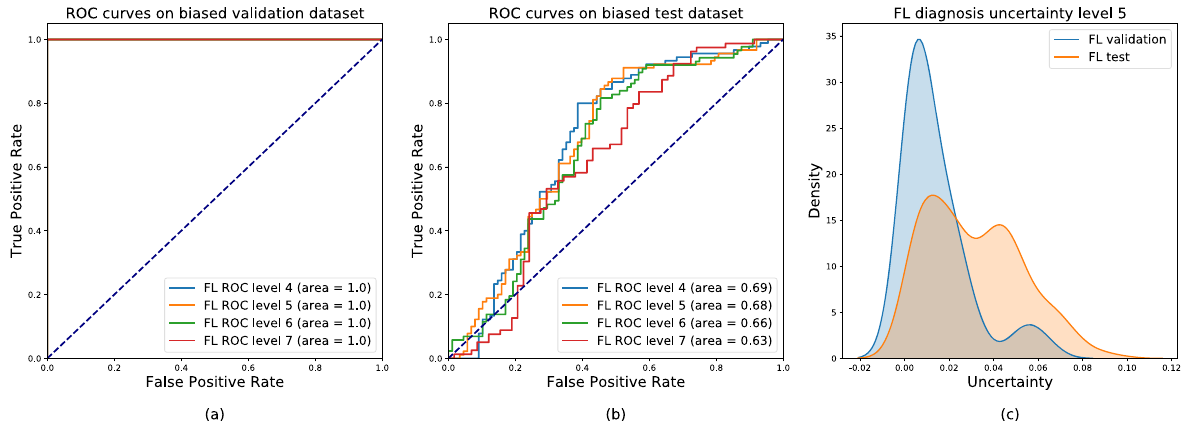
Fig. 6 Receiver-Operating Characteristics (ROC) and uncertainty distribution for the biased dataset. a ROC curves on the biased validation dataset (composed exclusively by internal slides). b ROC curves on the biased test dataset (composed by internal and external slides). c Uncertainty distribution for validation data (blue curve) and test data (orange